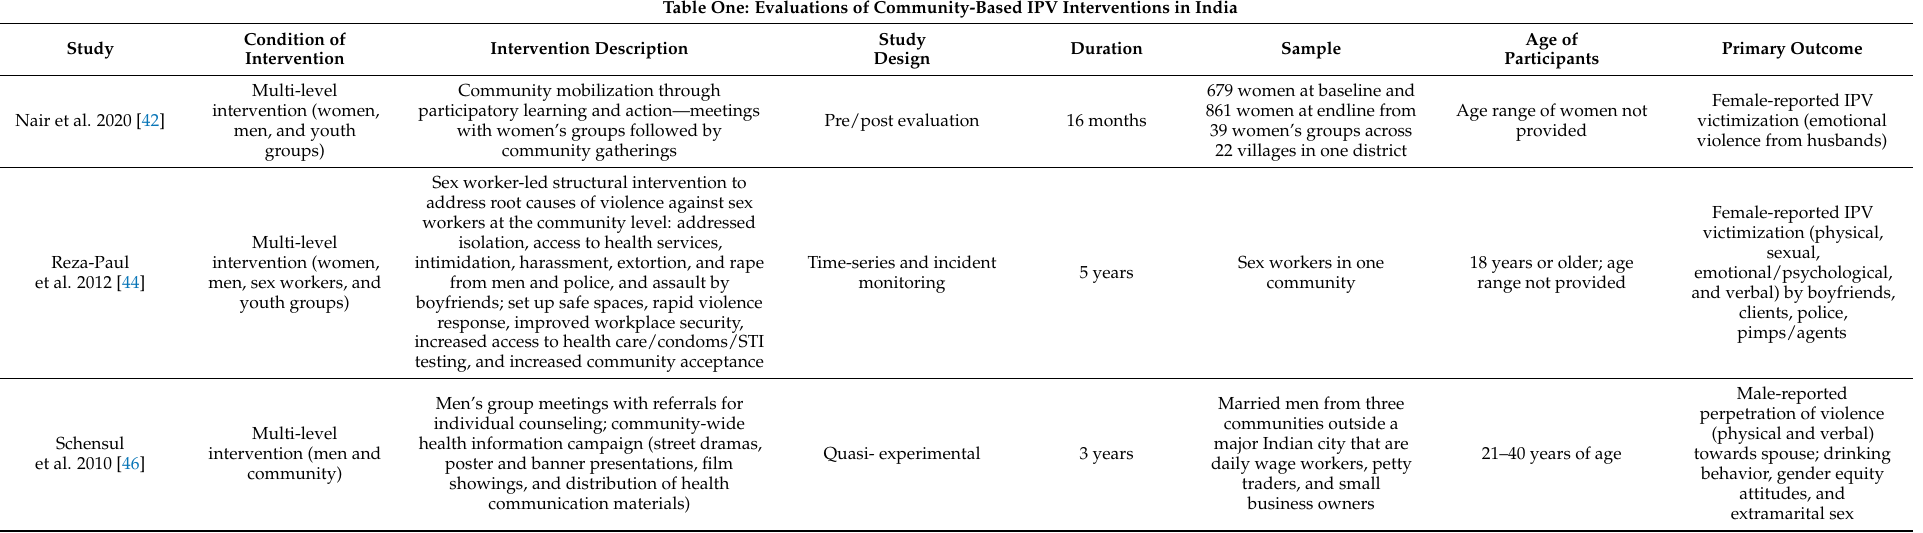
Table 1. Cont. Table One: Evaluations of Community-Based IPV Interventions in